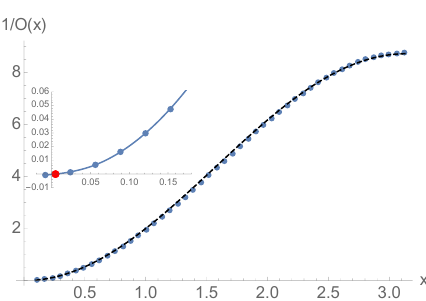
Figure 9 . We show our numerical result for the inverse of the two-point function G ( x; 0) evaluated as the one-point function in the presence of the source eq. (4.7) for (cid:14) = 0 : 01 and (cid:22) V = 0. The blue dots represent the numerical data. The behavior away from the core deviates only by a multiplicative factor (cid:24) 1 : 09 from the analytic result obtained without cuto(cid:11) h O ( x ) i (cid:0) 1 = k 0 (1 (cid:0) cos x ). To illustrate this, we plot with the black dashed line the function 1 : 09 k 0 (1 (cid:0) cos x ) showing good agreement with the numerics. The inset shows the behaviour near x = 0. Here, the solid line shows interpolation of the numerical data, which indicates that two-point function acquires large, negative values near the core. The red dot marks the point where the numerics diverge.